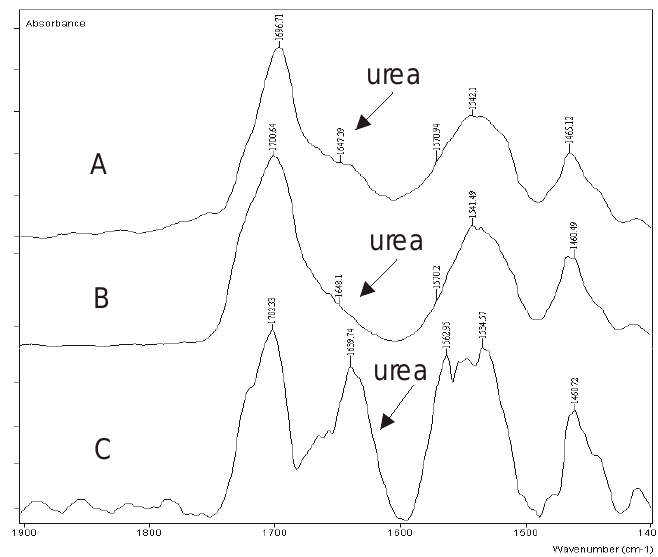
Figure 1 . The comparative FTIR spectrum of the catalyzed model system NCO/OH/H with: A)- the catalyst of zirconium K-KAT ® XC-6212 (King industries, Norwalk-USA); B)- the complex of Mn(III)-diacetylacetonatomaleate; C)-